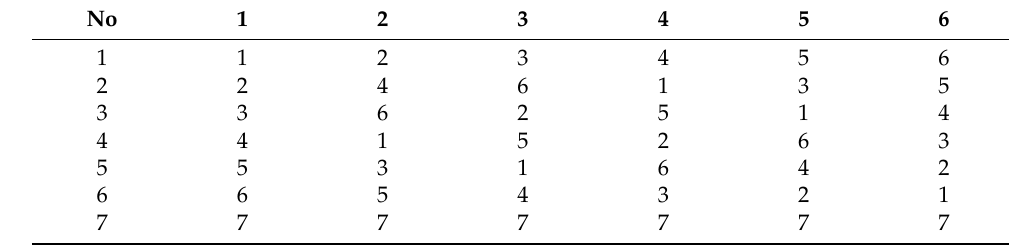
Table 1. Uniform design table U 7 (7 6